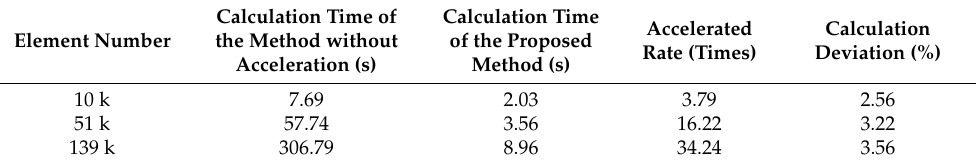
Table 1. The computation and accelerated times under different mesh elements [22].